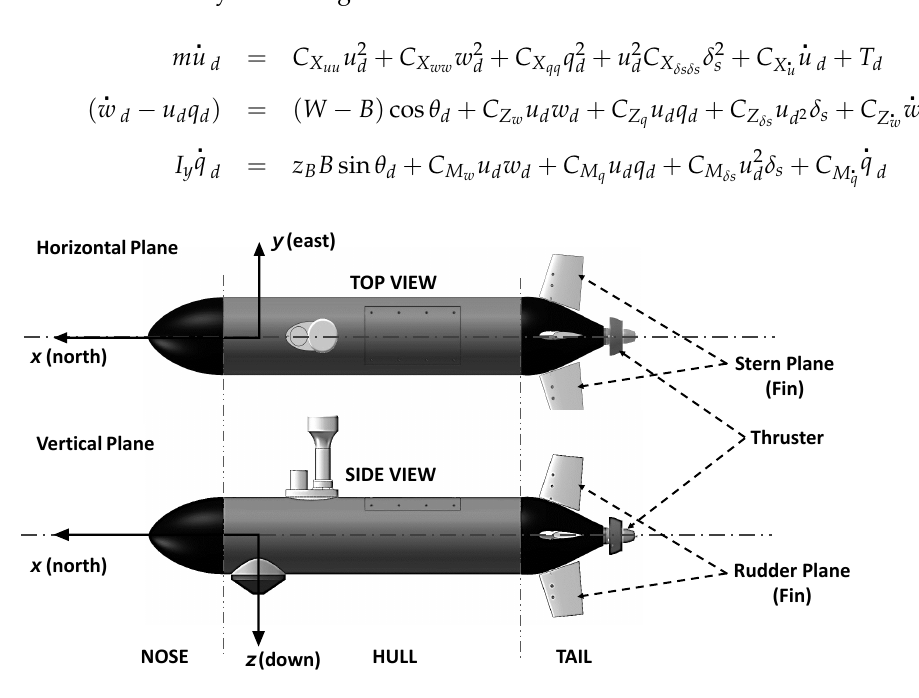
Figure 2. Different planes of